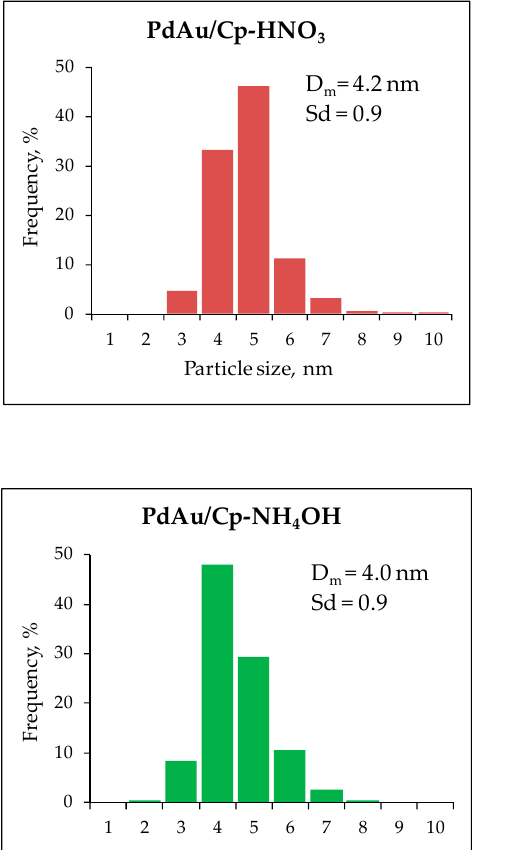
Figure 4. Metal particle size distribution and HRTEM images of PdAu/Cp ( a ), PdAu/Cp-HNO 3 ( b ) and PdAu/Cp-NH 4 OH ( c ) catalysts. XPS was used to study the electronic state of palladium, gold, oxygen, carbon and nitrogen in the studied bimetallic systems (Figure 5).